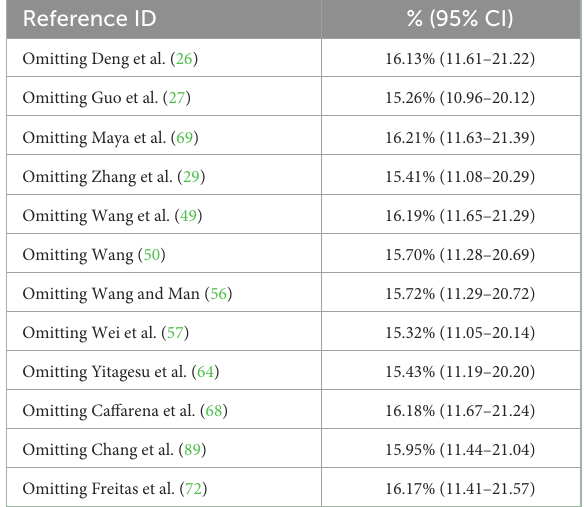
TABLE 6 Sensitivity analysis (decetion